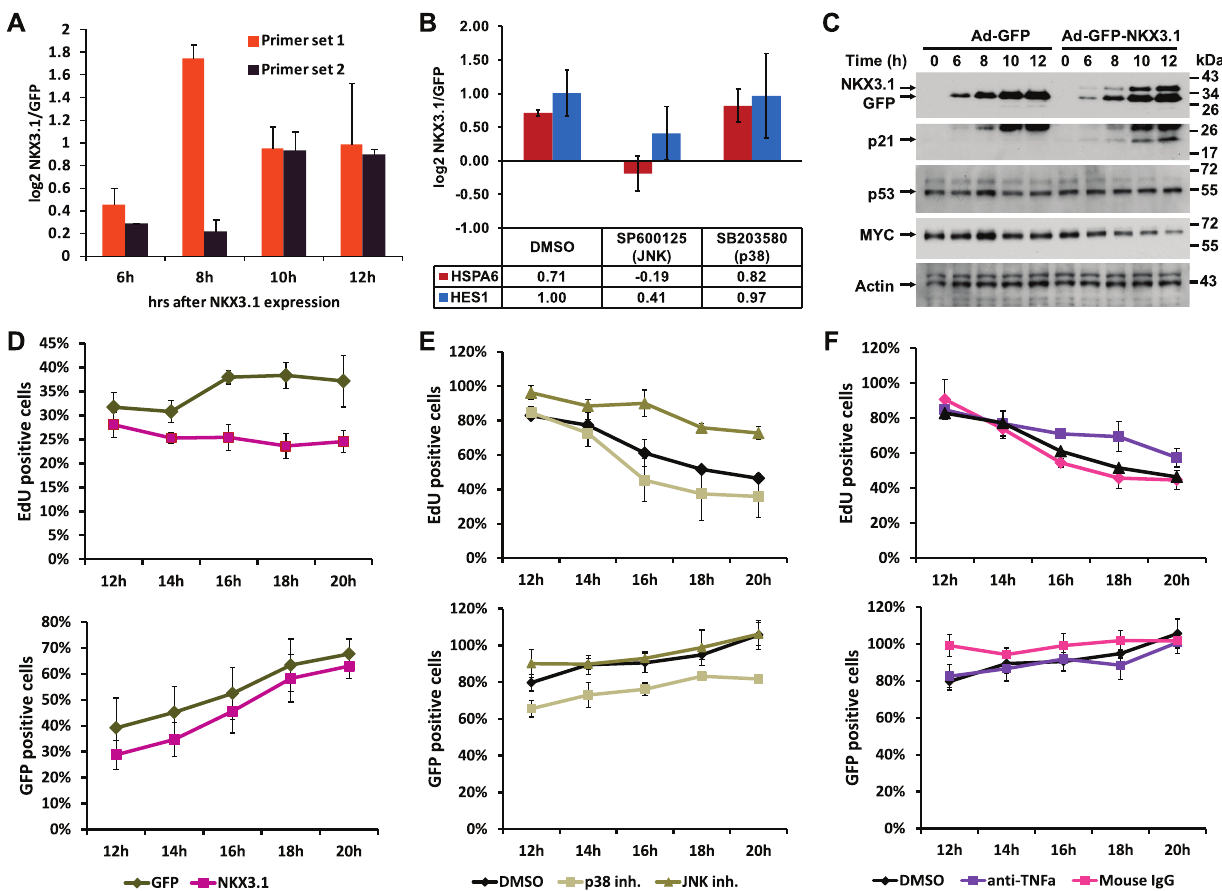
Figure 6. NKX3.1-induced changes in gene and protein expression. ( A ) Quantitative RT-PCR analysis of TNF α mRNA. LH cells were infected with adenoviruses driving the expression of either GFP alone or GFP and NKX3.1, and mRNA was isolated after the indicated time points (6, 8, 10, 12 hours). The RNA samples were analyzed by Q-PCR with two different primer sets amplifying TNF α mRNA, and expression values are shown as log2 transformed ratios of the mRNA level in NKX3.1 infected versus GFP infected cells (NKX3.1/GFP). Error bars indicate standard deviations obtained from two replicate measurements. ( B ) LH cells were infected with adenoviruses driving the expression of either GFP alone or GFP and NKX3.1. After 4 hours, 10 μM of the JNK inhibitor SP600125 or 10 μM of the p38 kinase inhibitor SB203580 were added followed by mRNA isolation after 6 hours. The levels of HSPA6 and HES1 were analyzed by Q-PCR. Expression values are shown as log2 transformed ratios of the mRNA level in NKX3.1 infected versus GFP infected cells (NKX3.1/GFP). Error bars indicate standard deviations obtained from two replicate measurements. ( C ) LH cells were infected with adenoviruses driving the expression of either GFP alone or GFP and NKX3.1, and protein lysates were prepared after the indicated time points (6, 8, 10, 12 hours). The expression of the indicated proteins was determined by immunoblotting. Cropped blot images are shown; see Figure S8. for full images. ( D ) LH cells were infected with Ad-GFP and Ad-GFP-NKX3.1 viruses, and the rate of DNA synthesis was measured by EdU incorporation after the indicated times